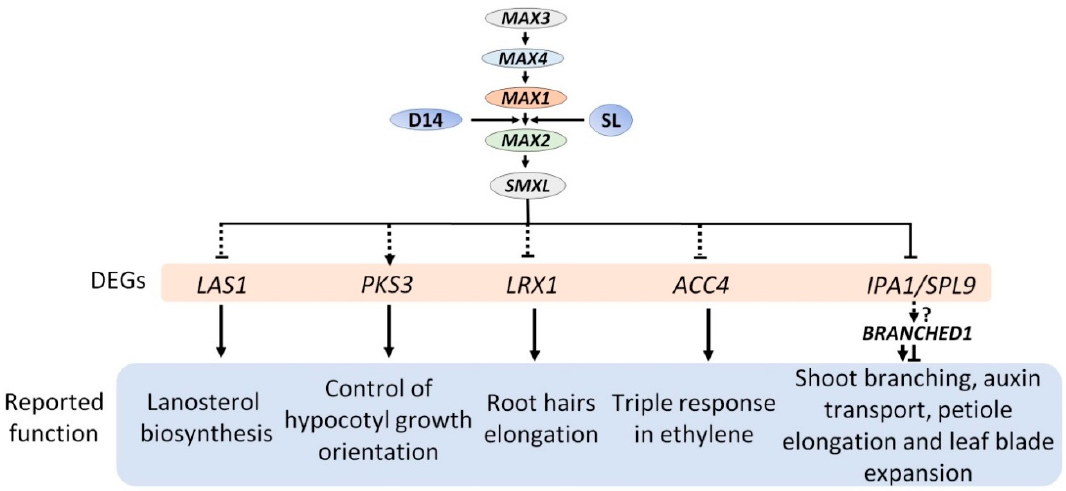
Figure 5. Proposed SL signaling pathways. DEGs means di ff erential expressed genes. Black arrows represent up-regulated genes, dotted lines, and question mark (?) represent unreported genes.